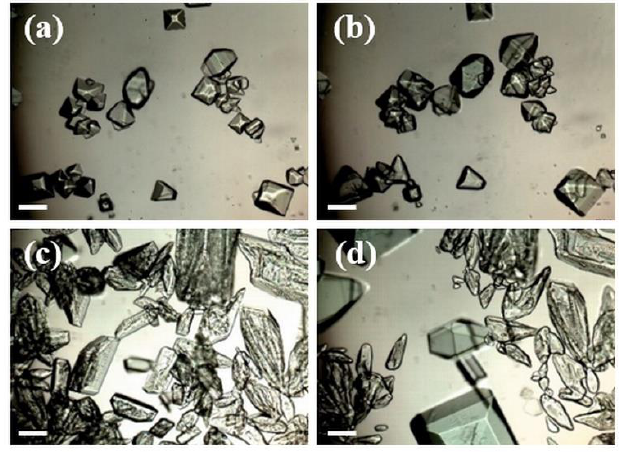
Figure 9. Nickel sulfate crystallized on microscope glass slide and imaged by optical microscope. Samples taken out: ( a , b ) at 40 °C and ( c , d ) at 70 °C, and imaged after 5 min and 60 min, respectively. Scale bar: 100 µm.